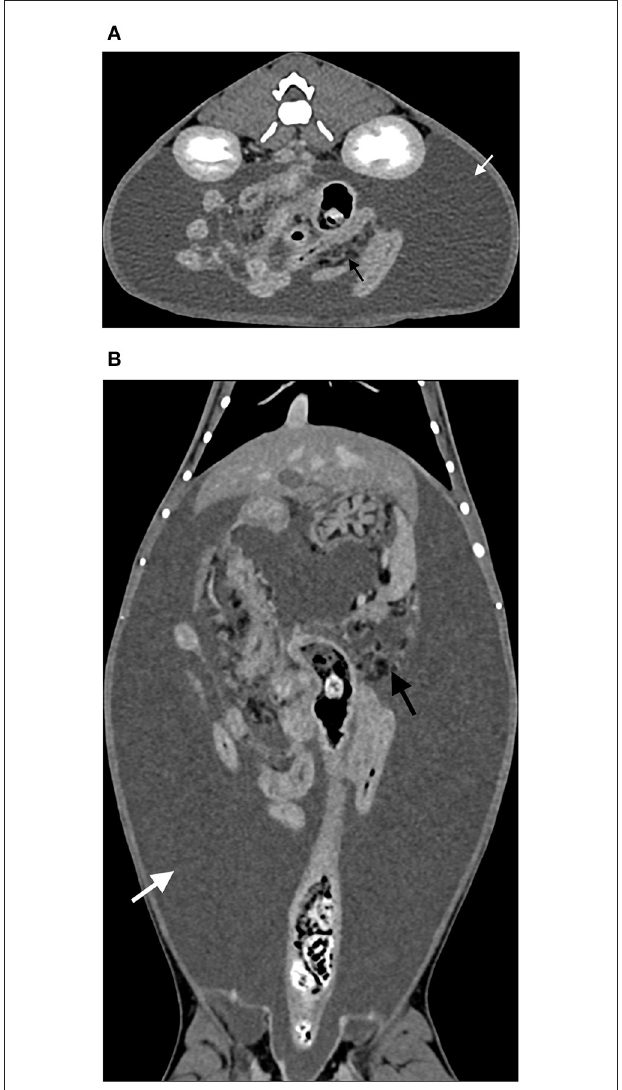
FIGURE 5 | Late post-contrast CT acquisition of the abdomen of C1 (same case as Figure 3 ). (A) Transverse image, soft tissue window, at the level of the kidneys (B) Dorsal multiplanar reconstruction image, soft tissue window, at the level of the descending colon. There is central gathering of the intestines and a large amount of surrounding peritoneal fluid (white arrow). Fat stranding is also visible (black arrow).